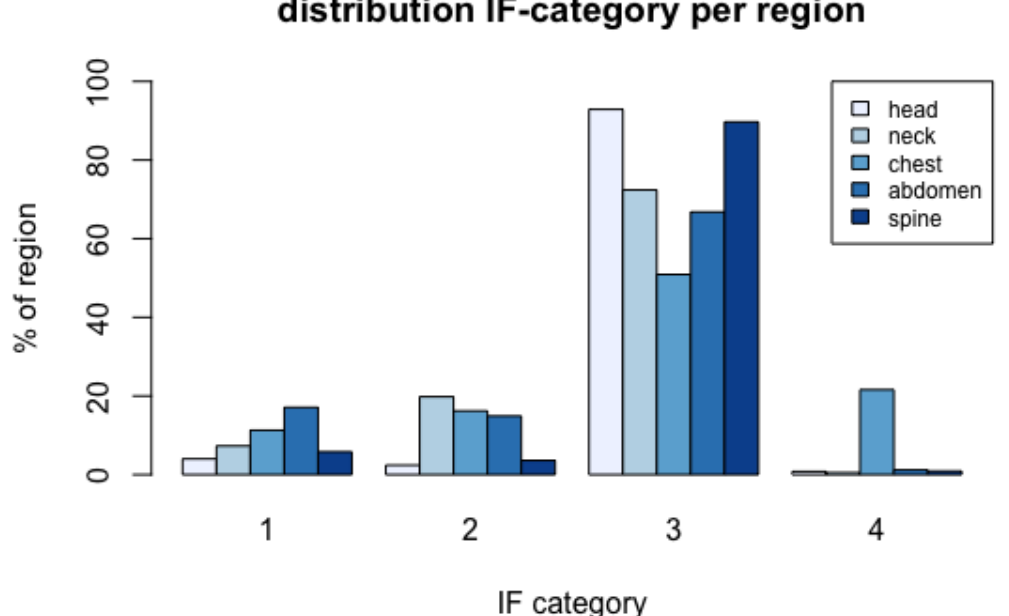
Figure 2. Distribution of incidental finding (IF) categories per body region investigated.